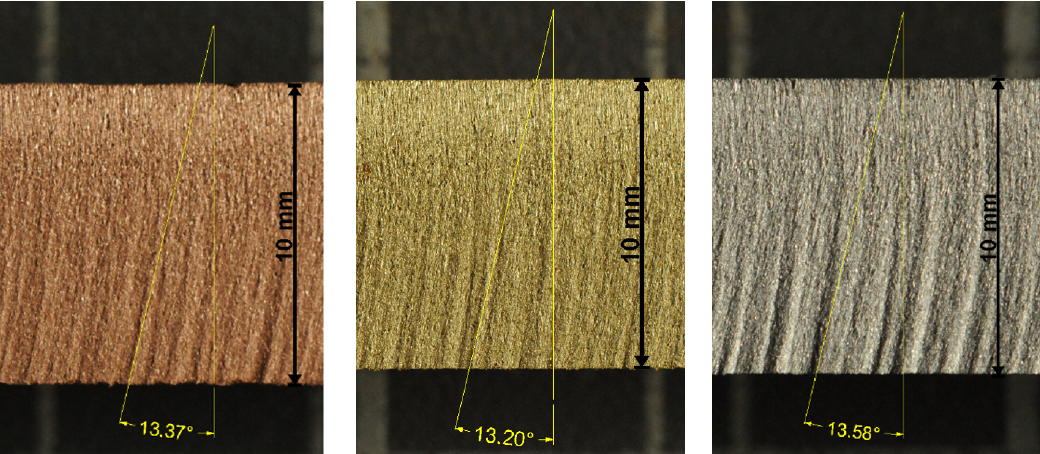
Figure 1. Steels and the respective average angles—the order from the left to the right (WRN norm): high strength steel (1.7131), tool steel (1.2436), stainless steel (1.4541), Hardox 500 (trademark of the SSAB).